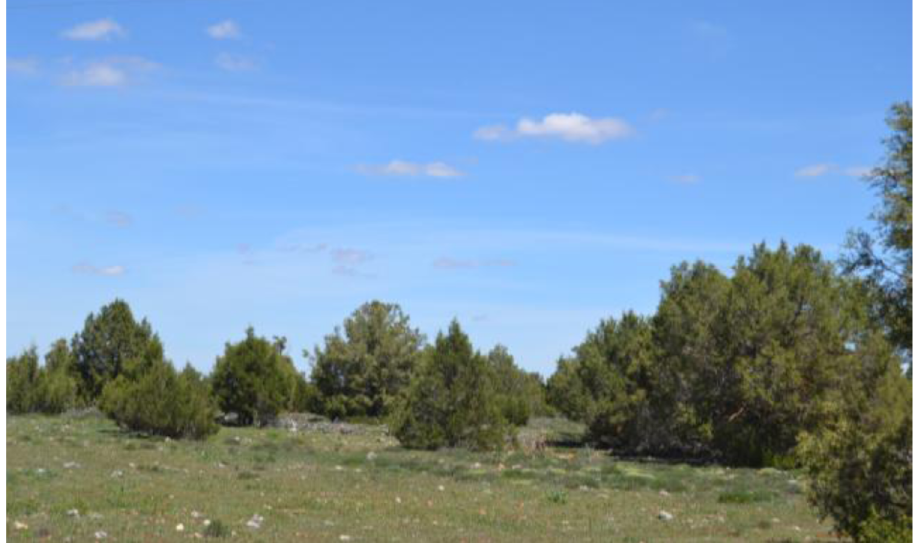
Figure 17. Juniperetum phoeniceo-thuriferae.